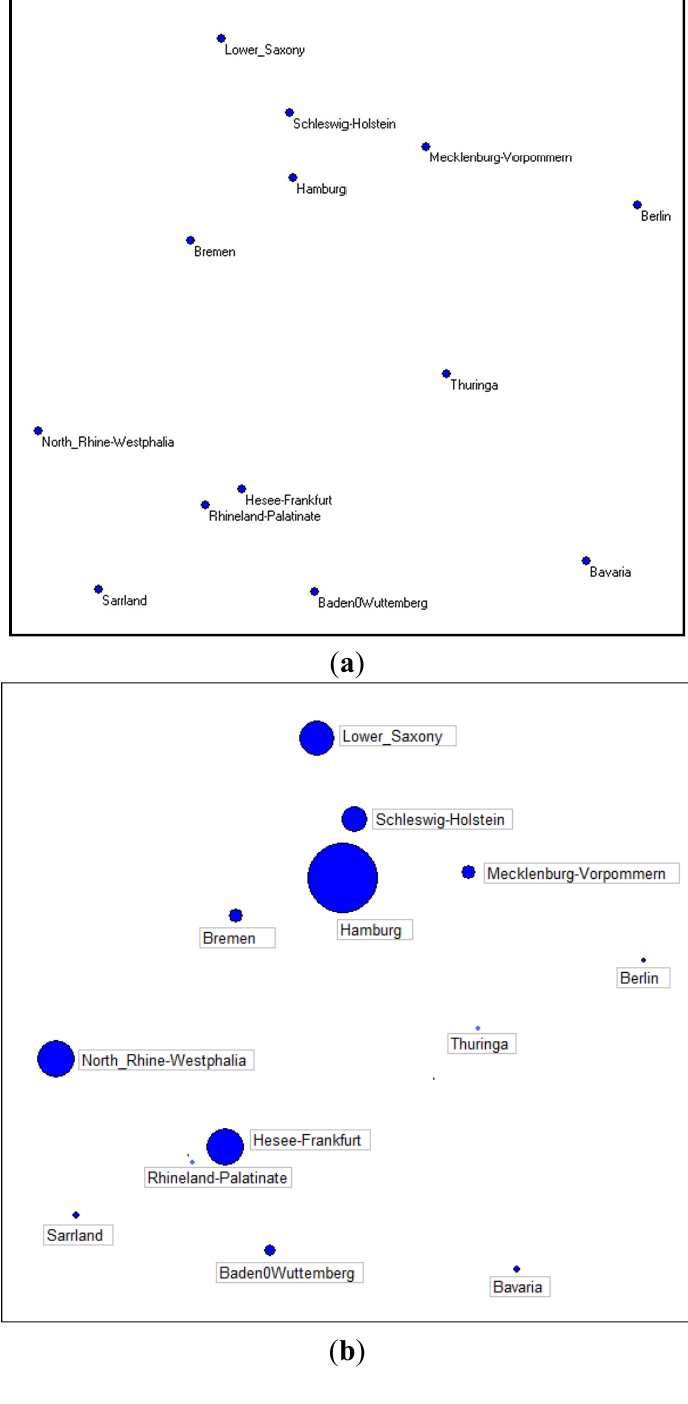
Figure 9. ( a ) Latitude and longitude of the first 13 German towns; ( b ) Quantity of suspected cases in the first 13 German